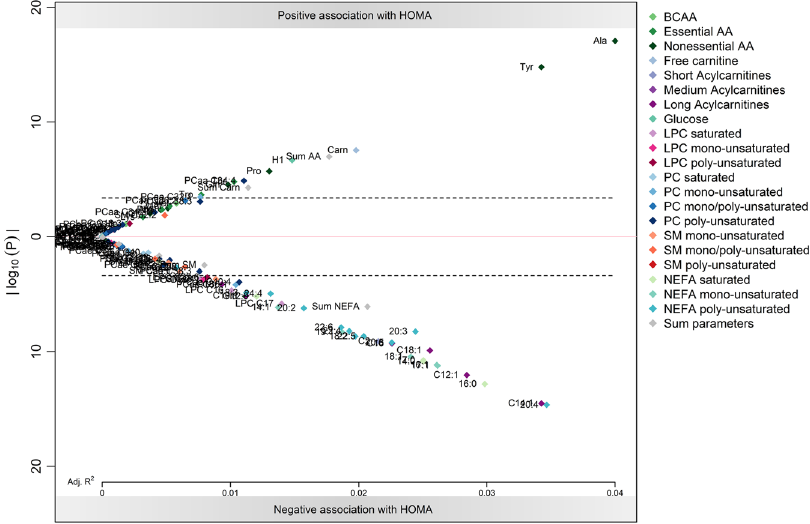
Figure 3. Results of the individual participant meta-analysis of the association of metabolites to HOMA levels. Log transformed p-values (y-axis) are plotted against adjusted R² (x-axis), with positive associations in the upper part of the figure (above 0) and negative associations in the lower part (below 0). Regression models were adjusted for sex. The dashed line indicates the Bonferroni-corrected significance level of 0.0004. Abbreviations: AA, amino acids; BCAA, branched-chain amino acids; LPC, lyso-phosphatidylcholine; NEFA, non-esterified fatty acid; PC, phosphatidylcholine; SM,